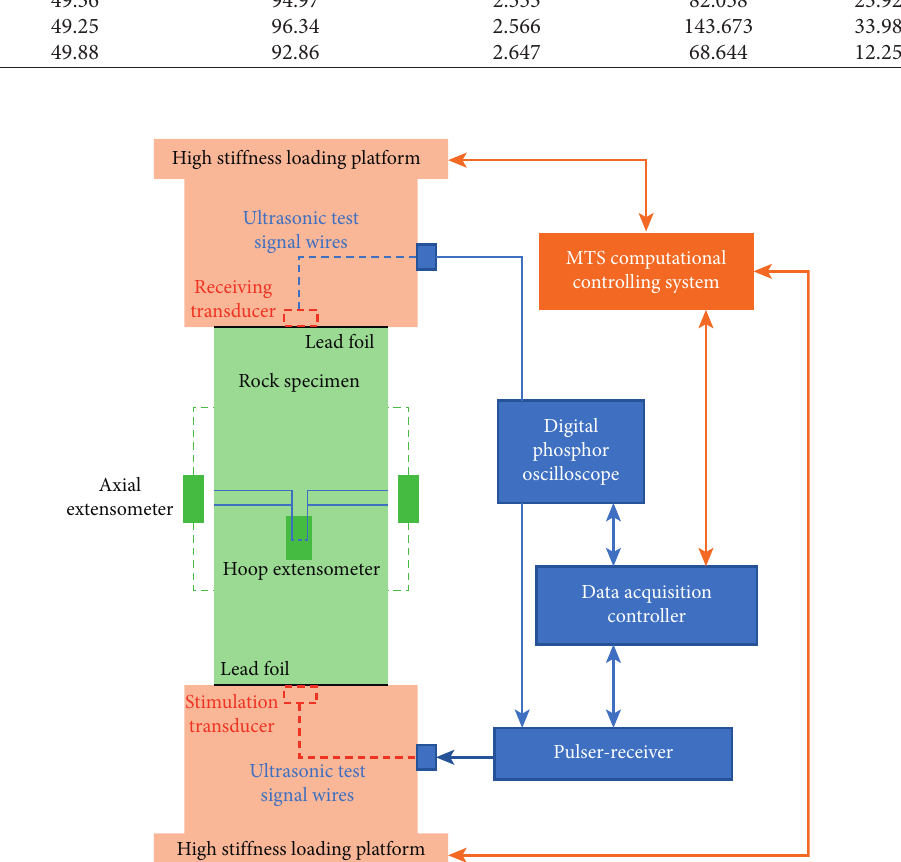
Figure 1: Schematic diagram of the coupling of the acoustic testing system and MTS815 system.